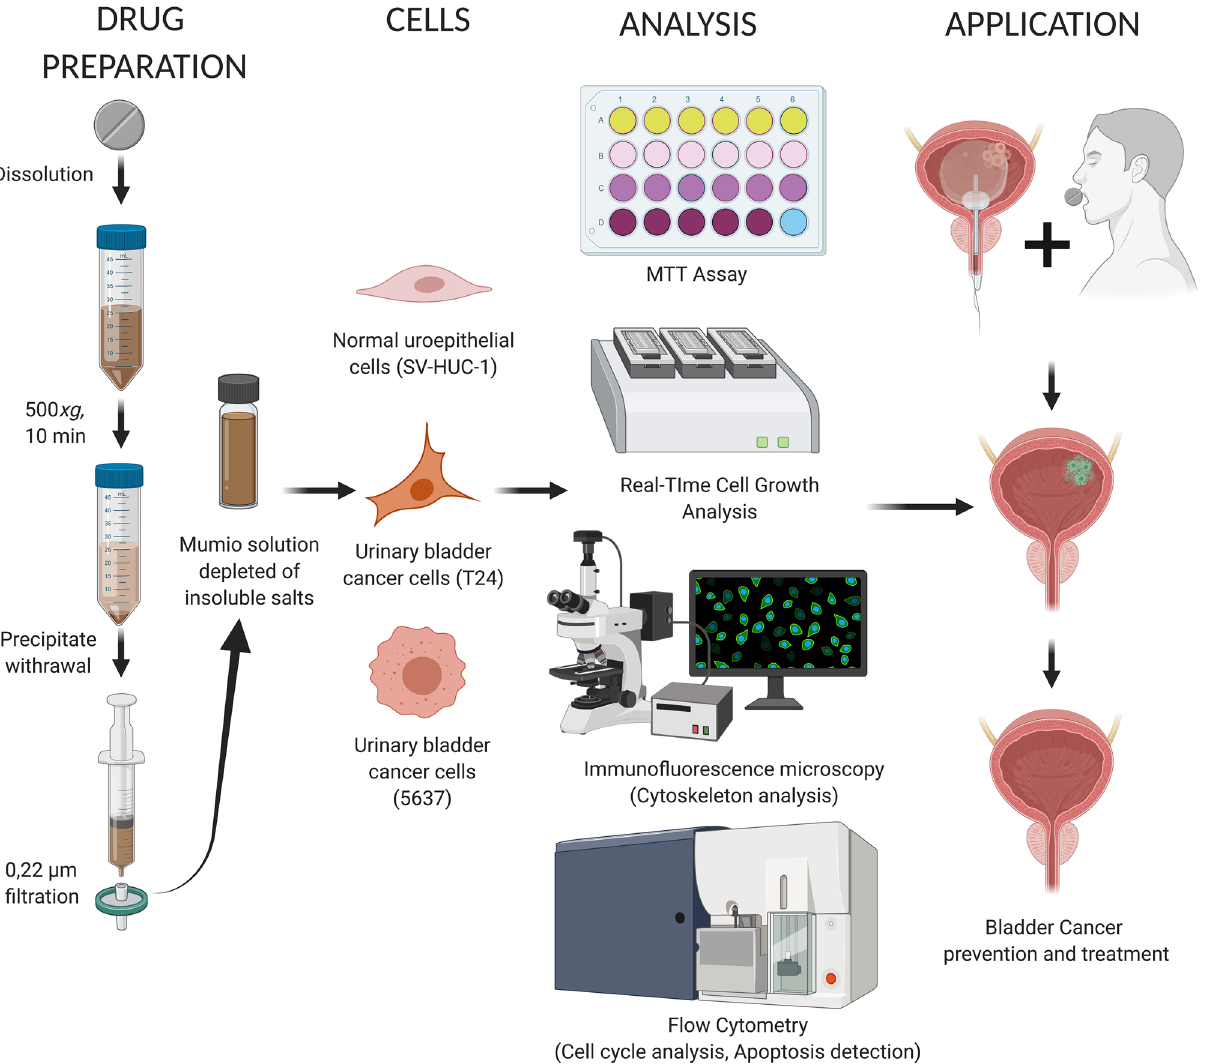
Figure 1. Workflow of the methods used to examine how Mumio affects normal and urinary bladder cancer cells. Created with